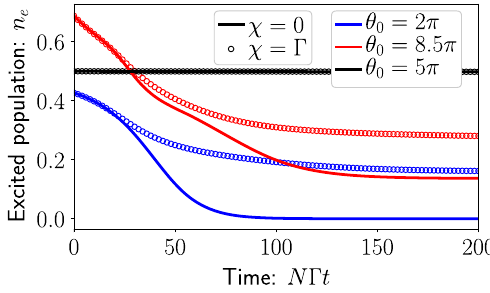
FIG. 14. Dynamics in the presence of elastic-cavity-mediated interactions, χ ≠ 0 . Results for the 20-level system with F g ¼ 9 = 2 starting in the j g F − 9 = 2 i V state and being initially excited e ¼ ˆ Σ (cid:2) by a drive [cf. Fig. 12]. Time evolution of the excited-state P 1 =N Þ population n h ˆ σ q e i for different initial pulse e ¼ ð m m e m areas θ 0 . We compare results for χ ¼ 0 (solid) with χ ¼ Γ (circles) computed with TWA for N ¼ 10 4 and 10 4 trajectories. We checked that the results agree with MF. When starting at the very flat saddle point of the potential ( θ 0 ≈ 5 π ), χ has no effect on the population dynamics. In the other cases, χ makes the system decay into a different dark